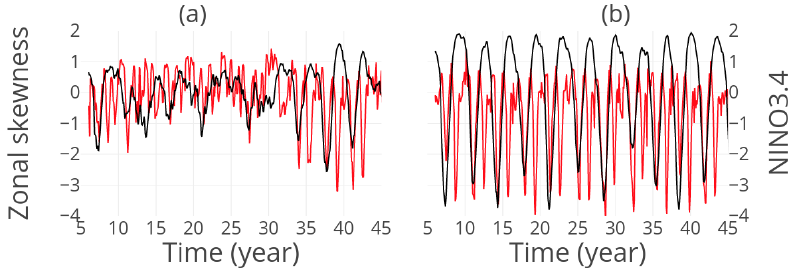
Figure A2. Zonal skewness of the degree field of the thermocline network with (cid:15) = 0 . 6 and a sliding window of 1 year in red, NINO3.4 index in black in the ZC model. (a) The subcritical ( µ = 2 . 7) and (b) the supercritical ( µ = 3 . 25)